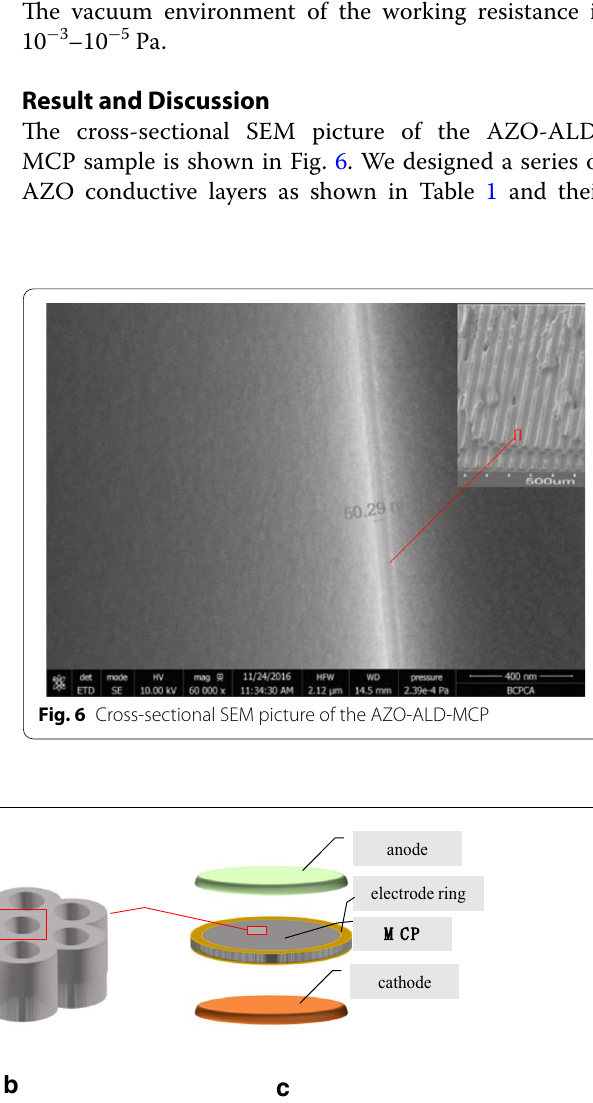
Fig. 4 Schematic diagram of ZnO and Al 2 O 3 growth sequence